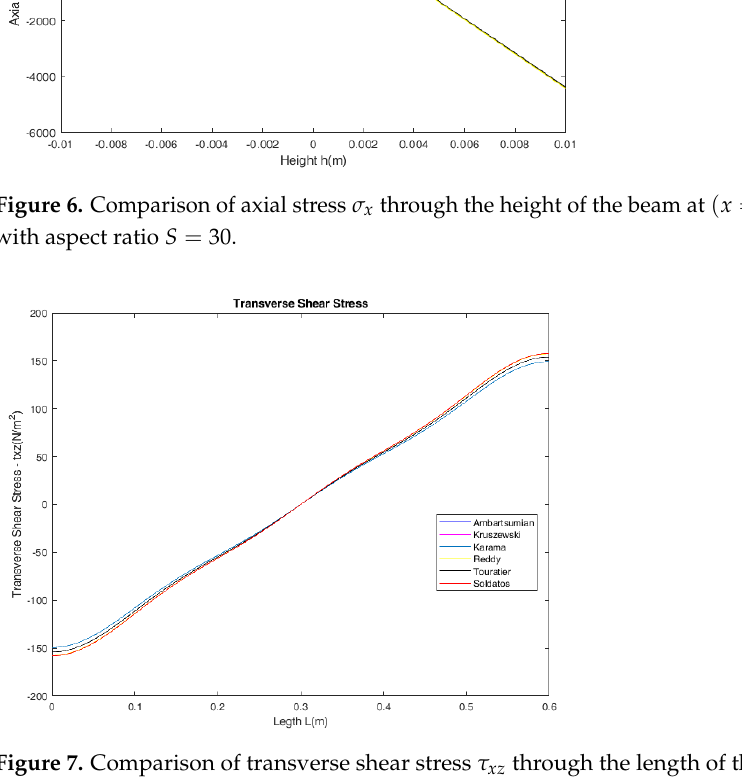
τ through the length of the beam at ( ) x z h 4 = , xz